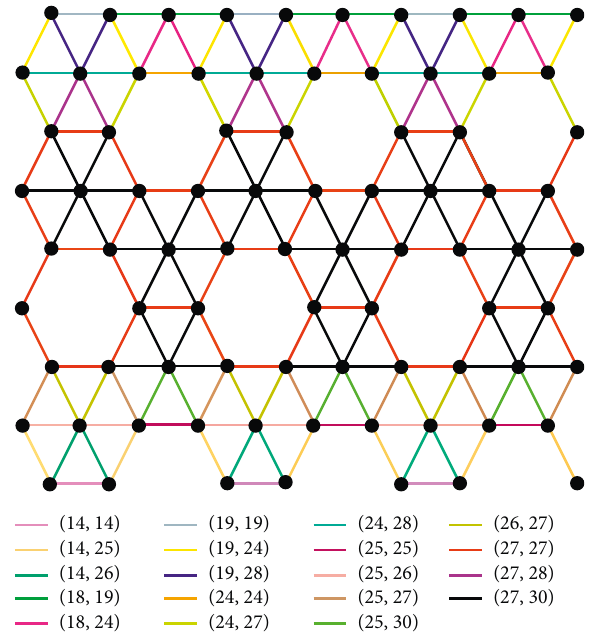
Figure 7: The edge partitions of BA ( X )[ 9 , 6 ] with respect to degree sum of neighbor